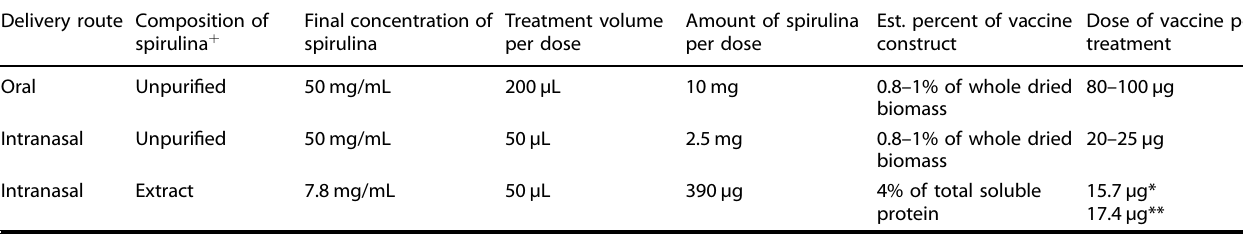
Table 1. Vaccine